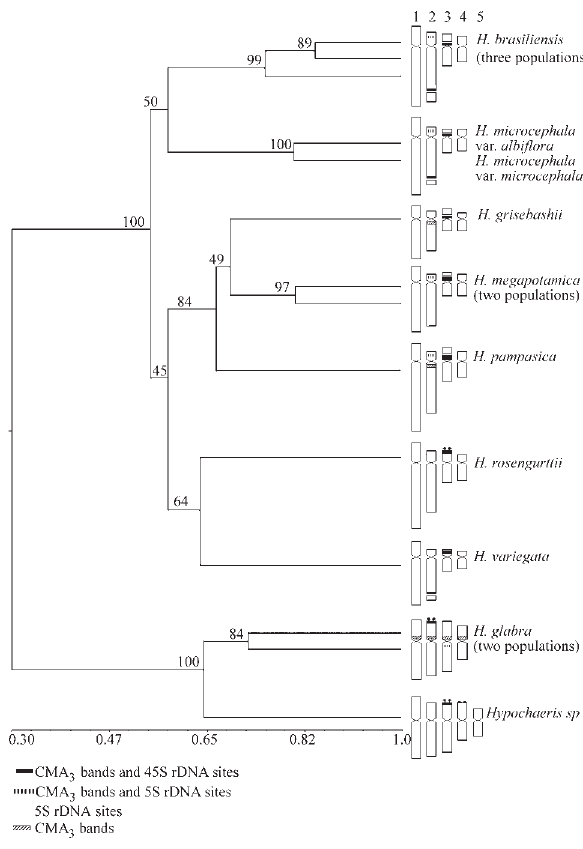
Figure 5 - Dendrogram showing the association between RAPD markers and chromosome data in Hypochaeris. The numbers above the branches are the boostrap values calculated for 1000